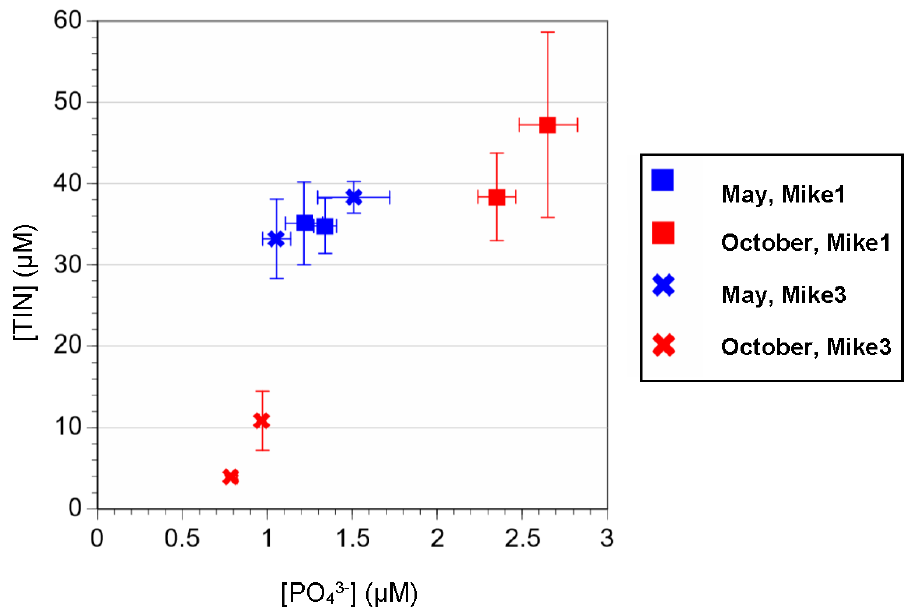
Figure 10. Soluble reactive phosphorus (SRP, PO 43 − ) and total inorganic nitrogen (TIN) concentrations ( μ M) in overlying water at the Mike1 (square) and Mike3 (cross) locations during May (blue) and October (red) 2015; standard error bars are included in both the x and y dimensions.